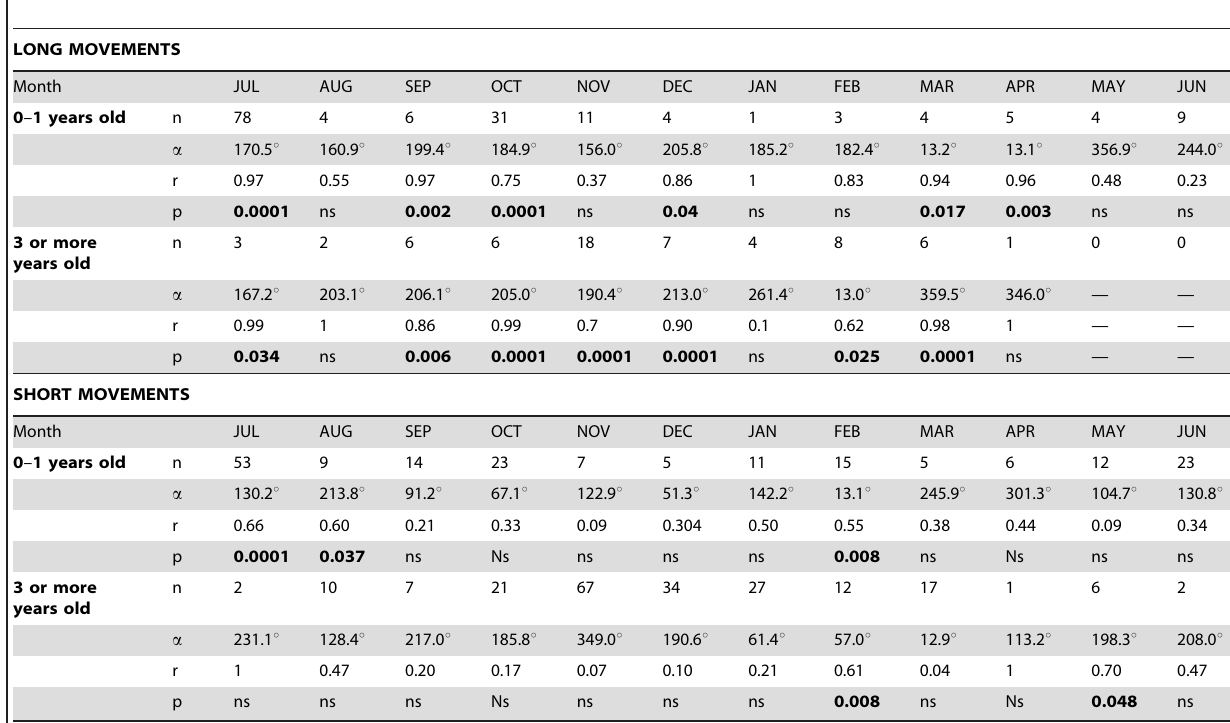
Table 1. Mean bearings of individual movements throughout the annual